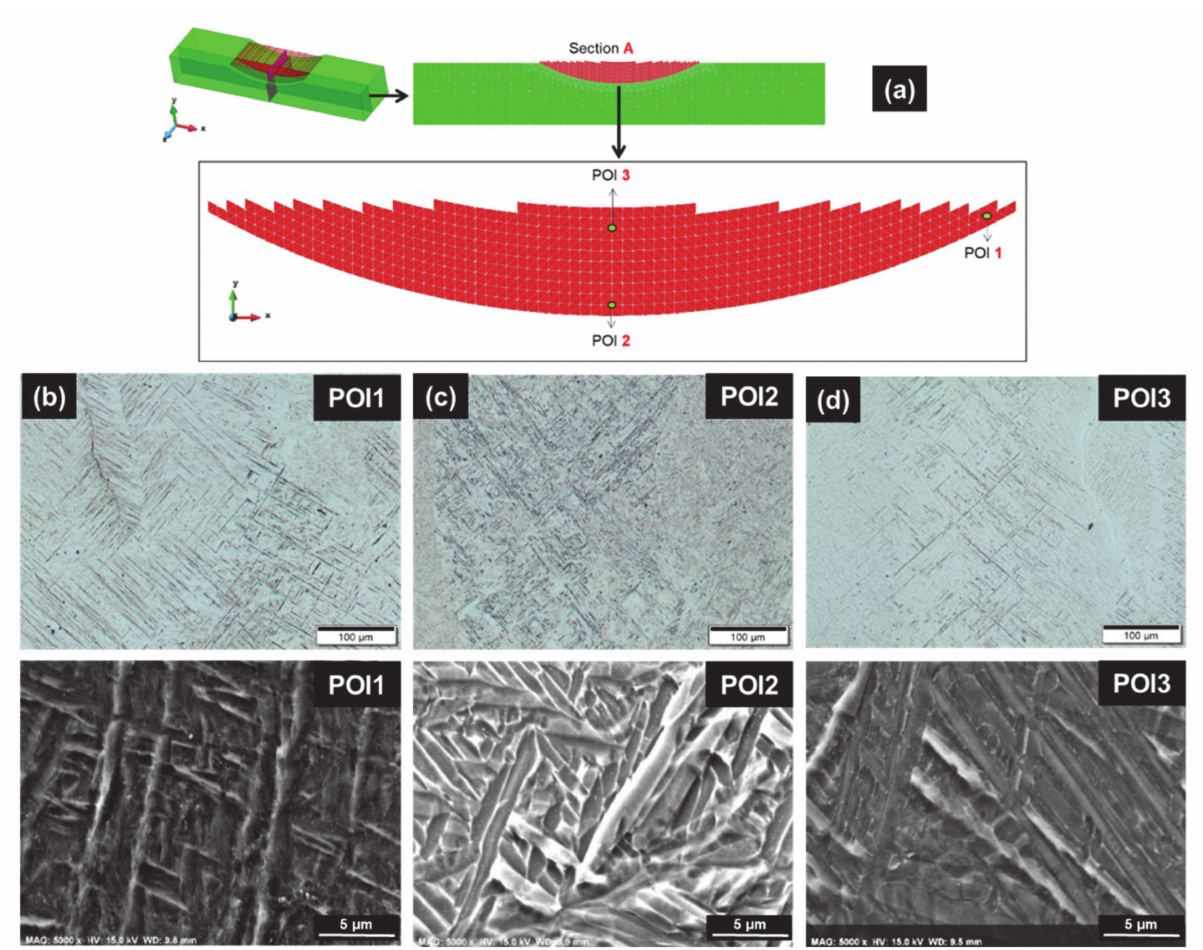
Figure 6. Microstructure in the as-built conditions; ( a ) location of the three points of interest POIs), and FE mesh; ( b – d ) light microscope (top) and zoom under SEM (bottom) for POIi—( b ) POI1: α (cid:48) martensite matrix made of thin orthogonal laths, with α m at prior β grain boundary; ( c ) POI2: α / β W basket-weave structure, with few coarsened discontinuous laths of “decomposed” α (cid:48) ; ( d ) POI3: α (cid:48) with some neighboring α / β W structure, and α m at prior β grain